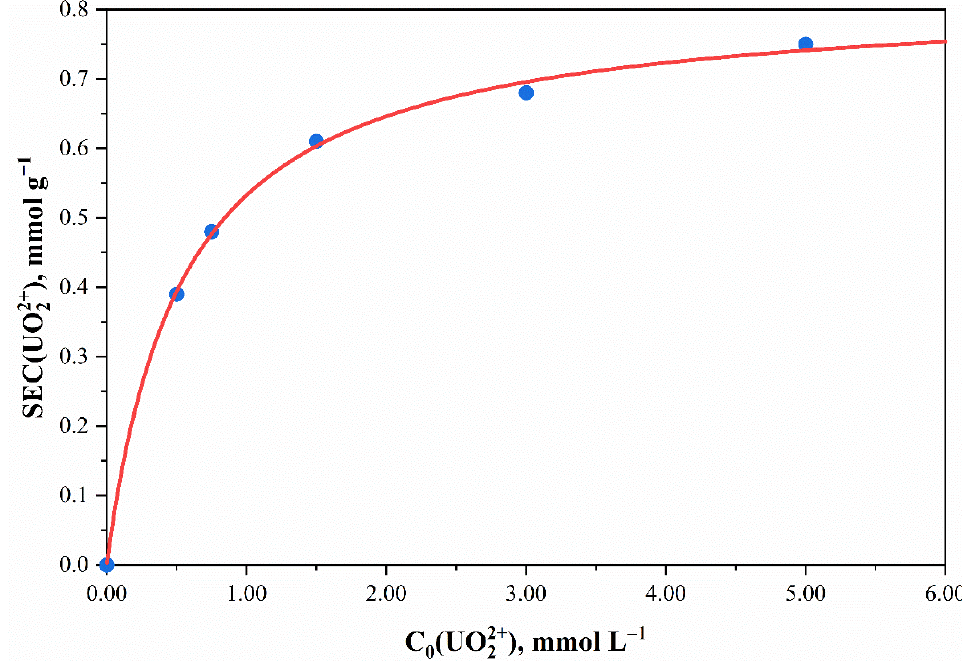
Figure 7. UO 22+ sorption isotherm of cotton cellulose samples phosphorylated with 0.802 mol L –1 H 3 PO 4 solution (phosphorus content—1.89 ± 0.19 wt.%; n (P) = 0.611 ± 0.061 mmol g –1 ). Points—experimental data; lines—calculated values in accordance with the Langmuir equation. The tempera- ture of the solutions during sorption experiments was t = 20 °C.